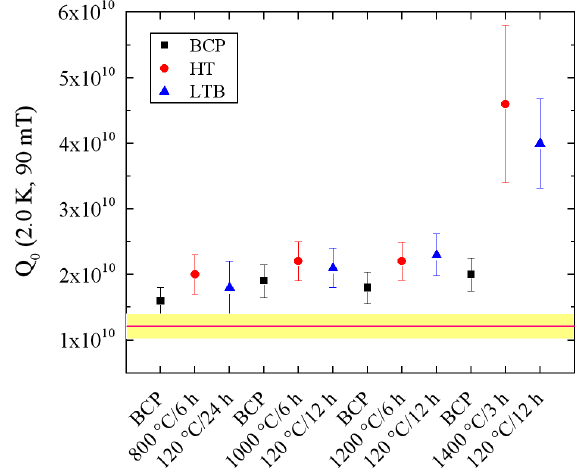
ð 2 : 0 K ; 90 mT Þ obtained after different treatments. FIG. 11. Q 0 ð 2 : 0 K ; 70 mT Þ measured on The solid line is the average Q 0 fine-grain, electropolished seven-cell cavities for the CEBAF upgrade. The yellow area indicates the standard deviation of the